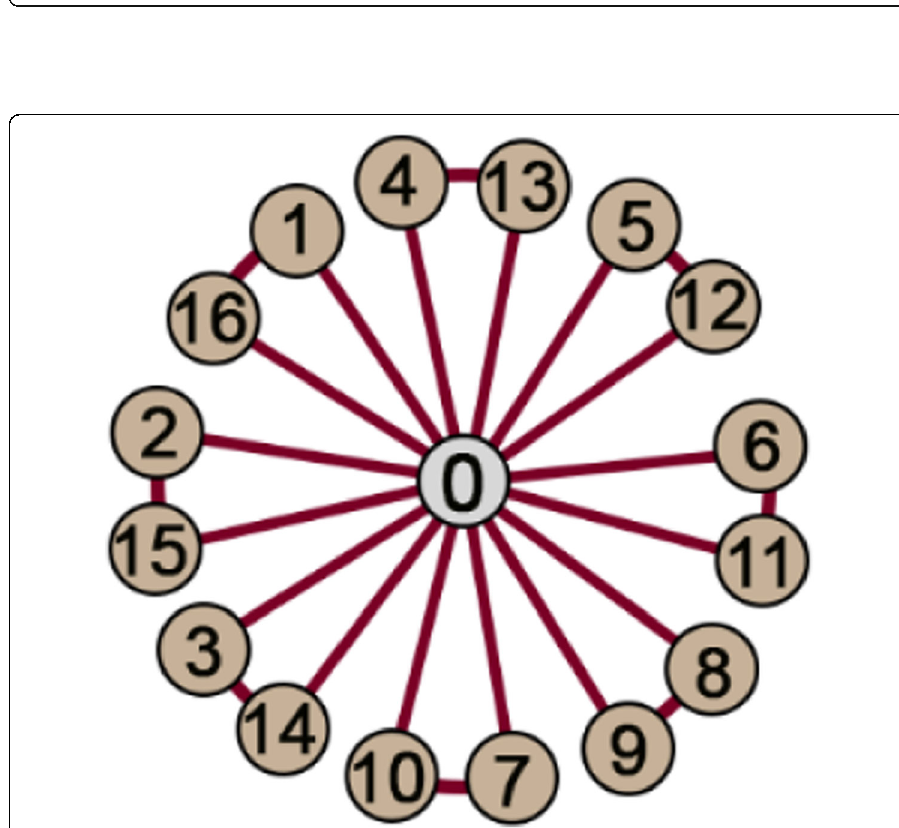
Fig. 2 An identity graph for the Z 17 = {0, 1, 2, … , 16} the group under addition modulo